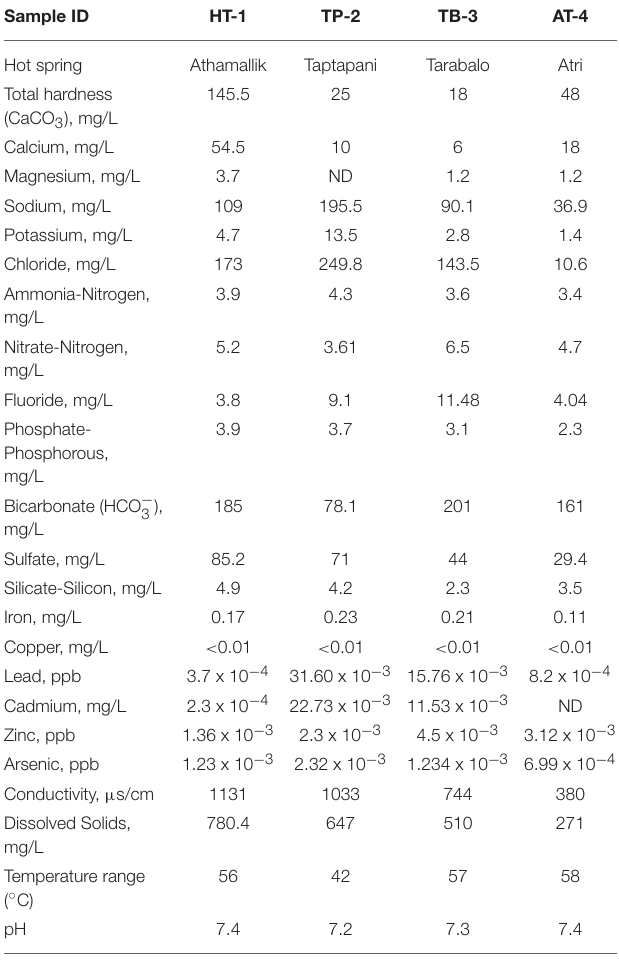
TABLE 1 | Physicochemical parameters of the four hot